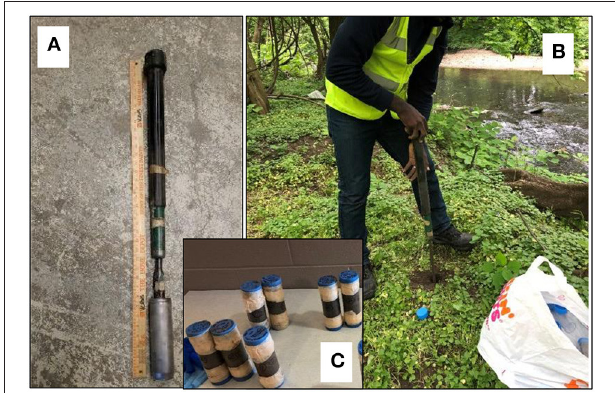
FIGURE 4 | (A) Auger used for sampling sediment in the bed and the banks. (B) Sampling up to 38cm with the auger. (C) Samples were collected in tubes with dimensions of 15.2cm (height) by 5 cm